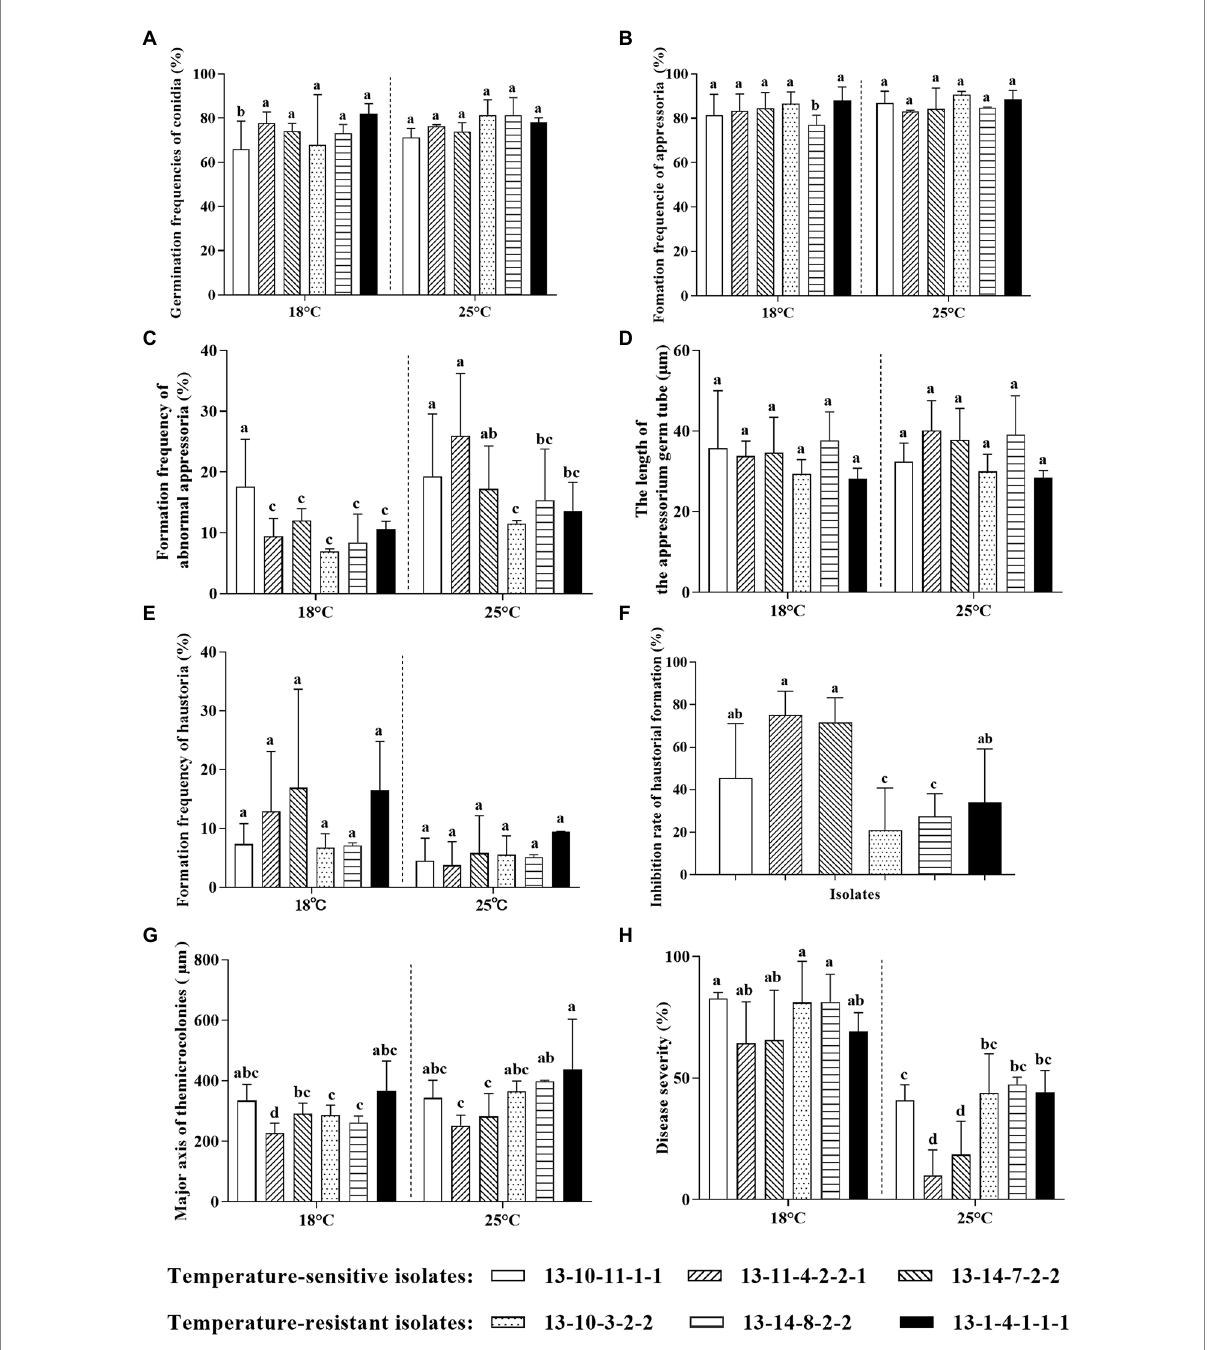
FIGURE 3 Differences in infection stages of high-temperature-sensitive and resistant isolates of B. graminis f. sp. tritici at 18 ° C and 25 ° C. (A) Germination frequencies of conidia; ( B) Formation frequencies of appressoria; ( C) Formation frequencies of abnormal appressoria; ( D) Lengths of appressorial germ tube (AGT); ( E) Formation frequencies of haustoria; ( F) Inhibition rate of haustoria formation; ( G) Major axis of microcolonies; ( H) Disease severity. The inhibition rate of haustoria formation was analyzed by one-way analysis of variance (ANOVA), while other data were analyzed using two-way ANOVA with Duncan’s multiple range test. The error bar showed standard error of three independent repeats. The different letters above the error bars indicated significant differences ( p ≤